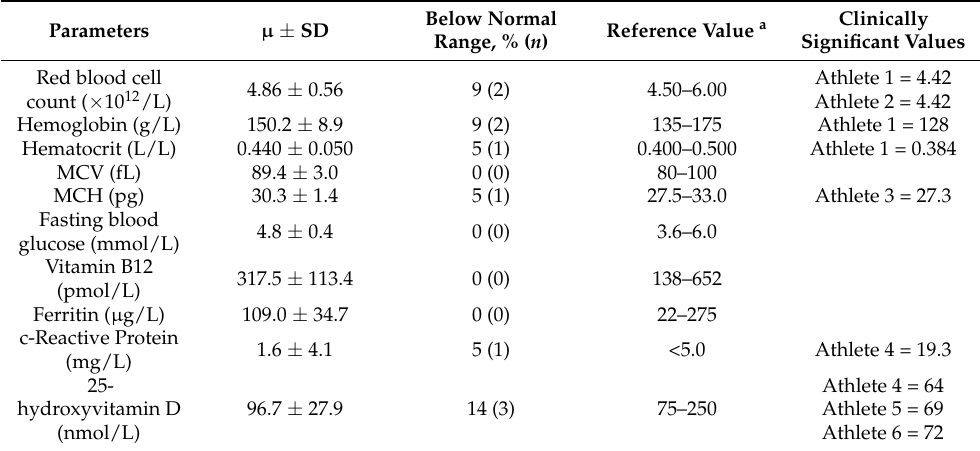
Table 4. Hematological parameters for assessment of nutrient deficiencies ( n = 22).